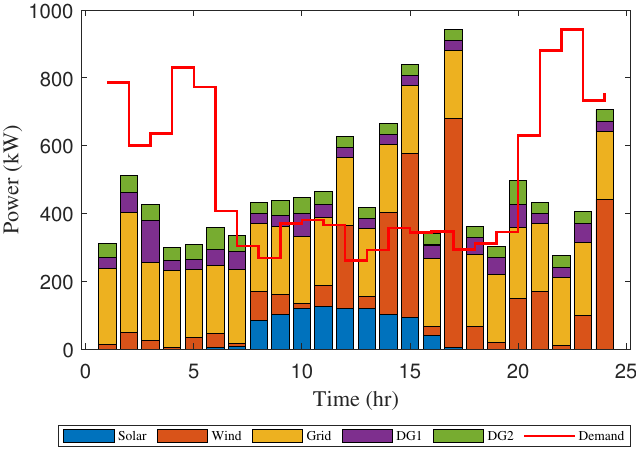
Figure 5. Optimal scheduling with forecast PV and wind data.